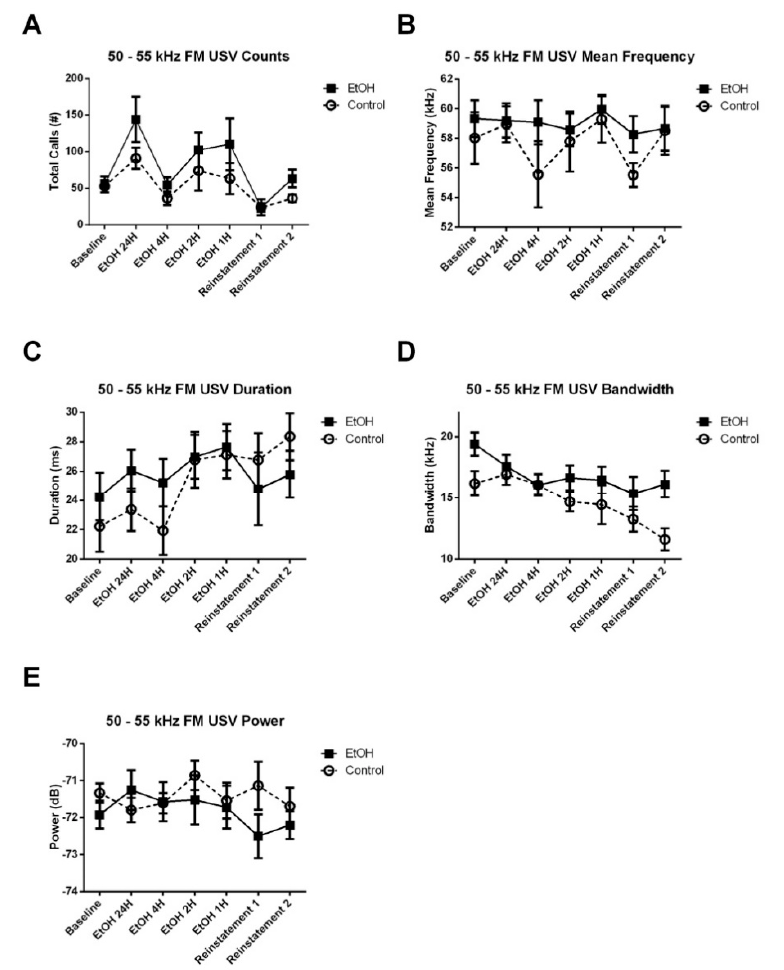
Figure 6. Effect of EtOH exposure on counts and acoustic characteristics of 50–55 kHz FM